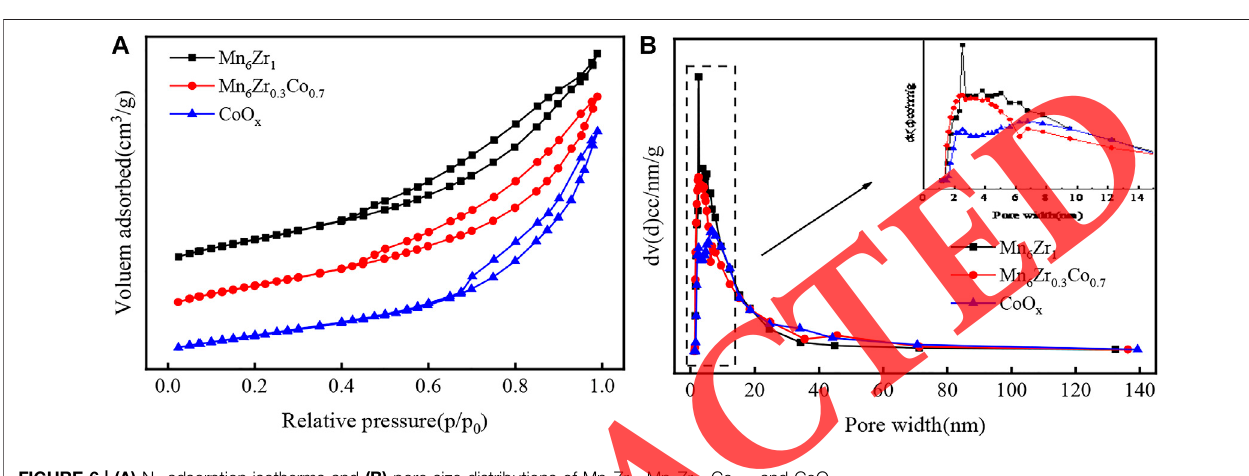
TABLE 1 | Surface areas, pore-volume, and average pore diameter of the samples.